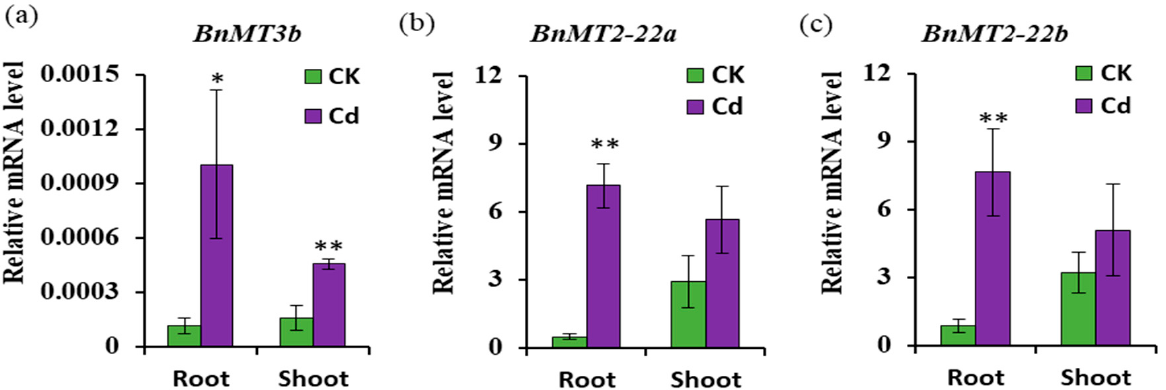
Figure 6. Expression levels of BnMT3b , BnMT2-22a and BnMT2-22b in response to Cd treatment. ( a – c ) Relative expression levels of BnMT3b ( a ), BnMT2-22a ( b ) and BnMT2-22b ( c ) under normal (CK) or Cd treatment (Cd) for 7 days. Data are mean ± SD, n = 3. Statistical significance was analyzed using Student’s t test, and was indicated by * ( p < 0.05) or ** ( p < 0.01).